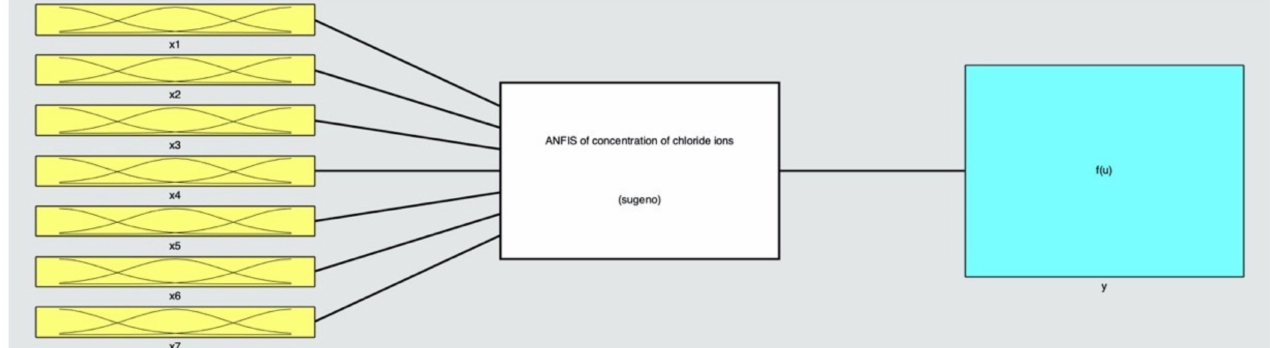
Figure 16. Schematic diagrams of neuro-fuzzy inference system (ANFIS).